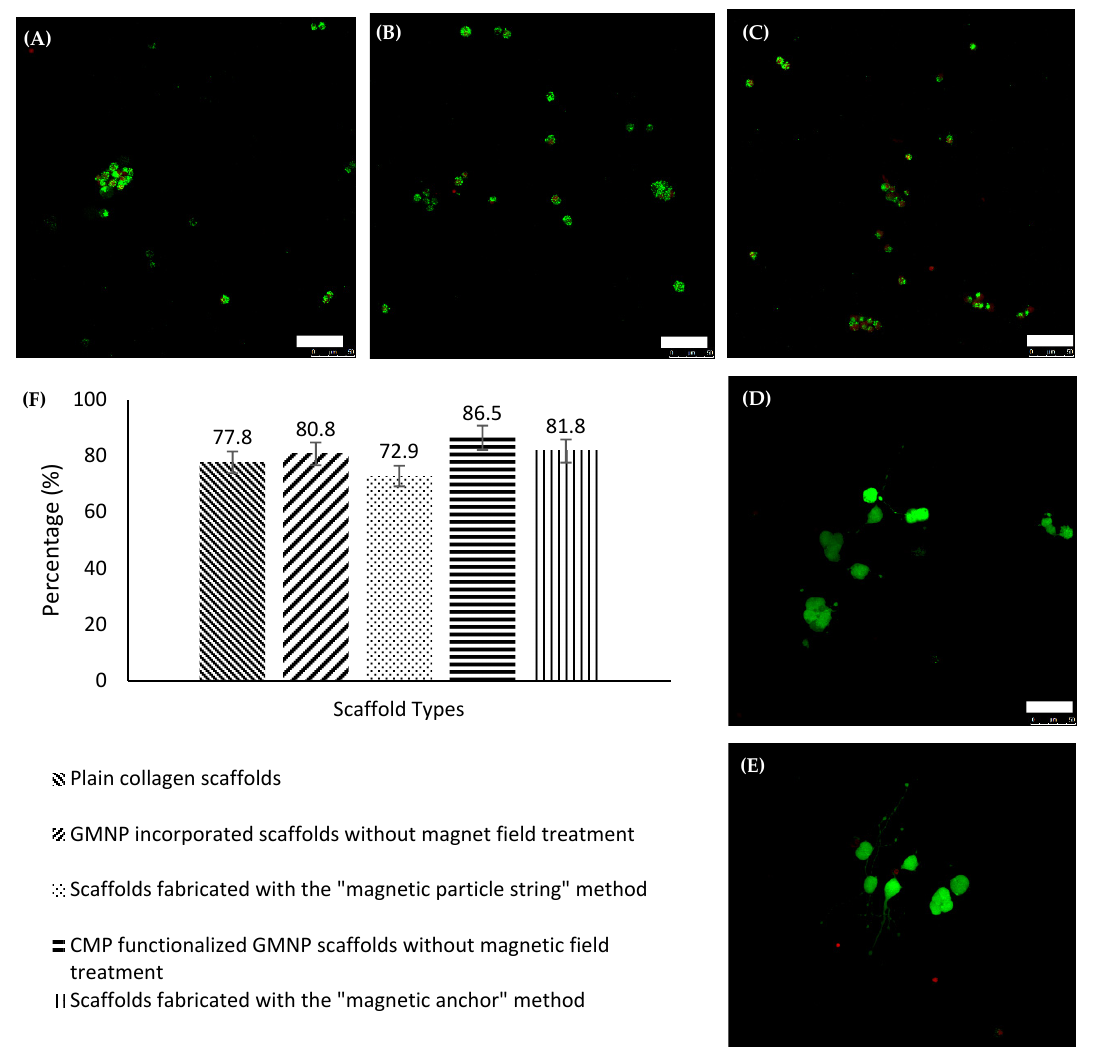
Figure 7. Confocal images of live/dead staining for PC12 cells within ( A ) plain collagen scaffolds, ( B ) GMNP-incorporated collagen scaffolds without magnetic field treatment, ( C ) scaffolds fabricated with the “magnetic particle string” method, ( D ) CMP-functionalised GMNP collagen scaffolds without magnetic field treatment, and ( E ) scaffolds fabricated with the “magnetic anchor” method. ( F ) shows the bar chart of the percentage of live cells within hydrogels of every treatment group. Scale bar = 50 µm.